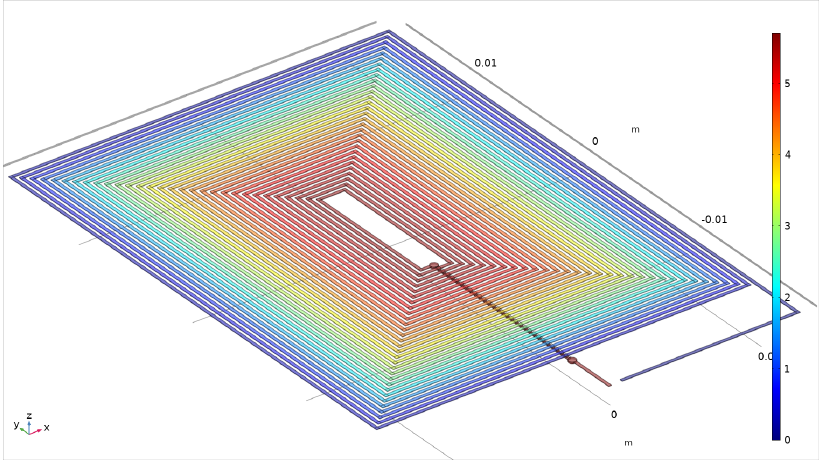
Figure 9. Calculated voltage distribution for the surface current model , expressed in V. The contour-plot of the magnetic field norm on the cores, together with its direction (gray arrows), is reported in Figure 10 for two time instants, one corresponding to zero current ( t = 0 s) and the other to the current peak ( t = 25 µ s), on the left and right side of the figure, respectively, when a 150 µ T external field is applied. Black arrows show the excitation current